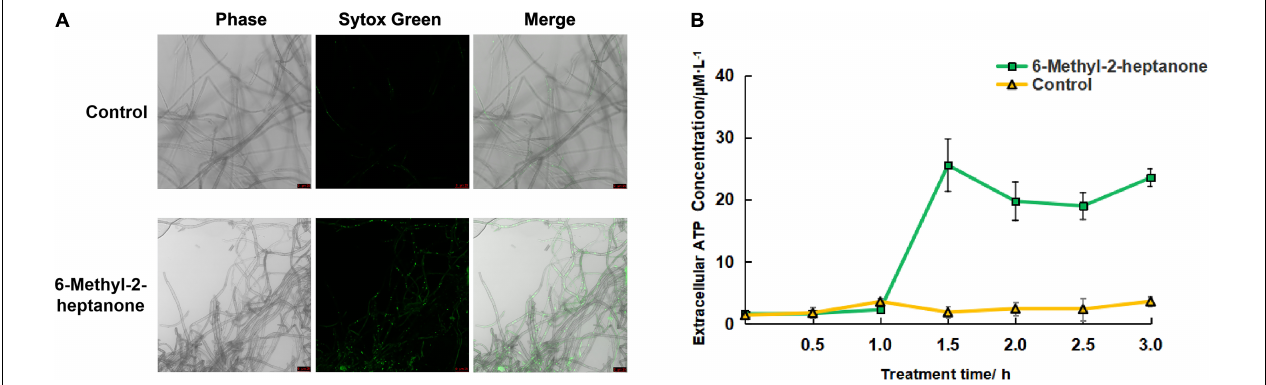
FIGURE 3 | Effects of 6-methyl-2-heptanone on the cell-membrane permeability of A. solani hyphae. (A) Fluorescence microscopy imaging of A. solani hyphae treated with 6-methyl-2-heptanone and a control group. Membrane permeability changes in A. solani mycelial cells were detected using SYTOX Green dye after a 6-h incubation with an EC 50 value of 6-methyl-2-heptanone. Green fluorescence illumination in treated samples signifies membrane damage in fungal cells. The phase channel showed all fungal cells on bright-field images, and the SYTOX Green channel showed cells attached or inserted with SYTOX Green labeled; the merge channel showed the proportion of SYTOX Green-labeled cells. (B) Effects of 6-methyl-2-heptanone on ATP release from A. solani . The changes in the extracellular ATP levels of A. solani represent cell-membrane damage. The ATP level was measured using an ATP kit based on a luminescent ATP assay and is presented in relative light units. The results are presented as the means ± SDs ( n =